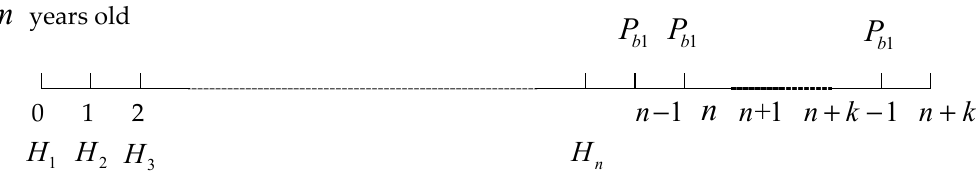
Figure 1. Schematic diagram of the life cycle of insured employees, premium payment and pension withdrawals.